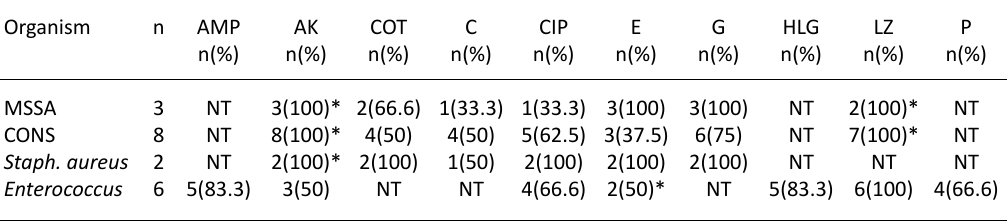
table 3. Antibacterial Susceptibility pattern of Gram Positive cocci associated with vaginitis in infertility patients including CLSI guidelines